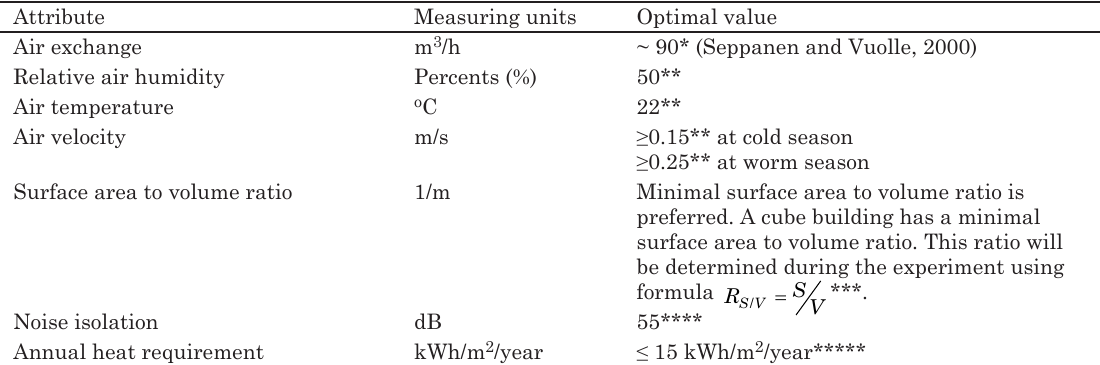
Table 2. optimal values for the selected attributes attribute Measuring